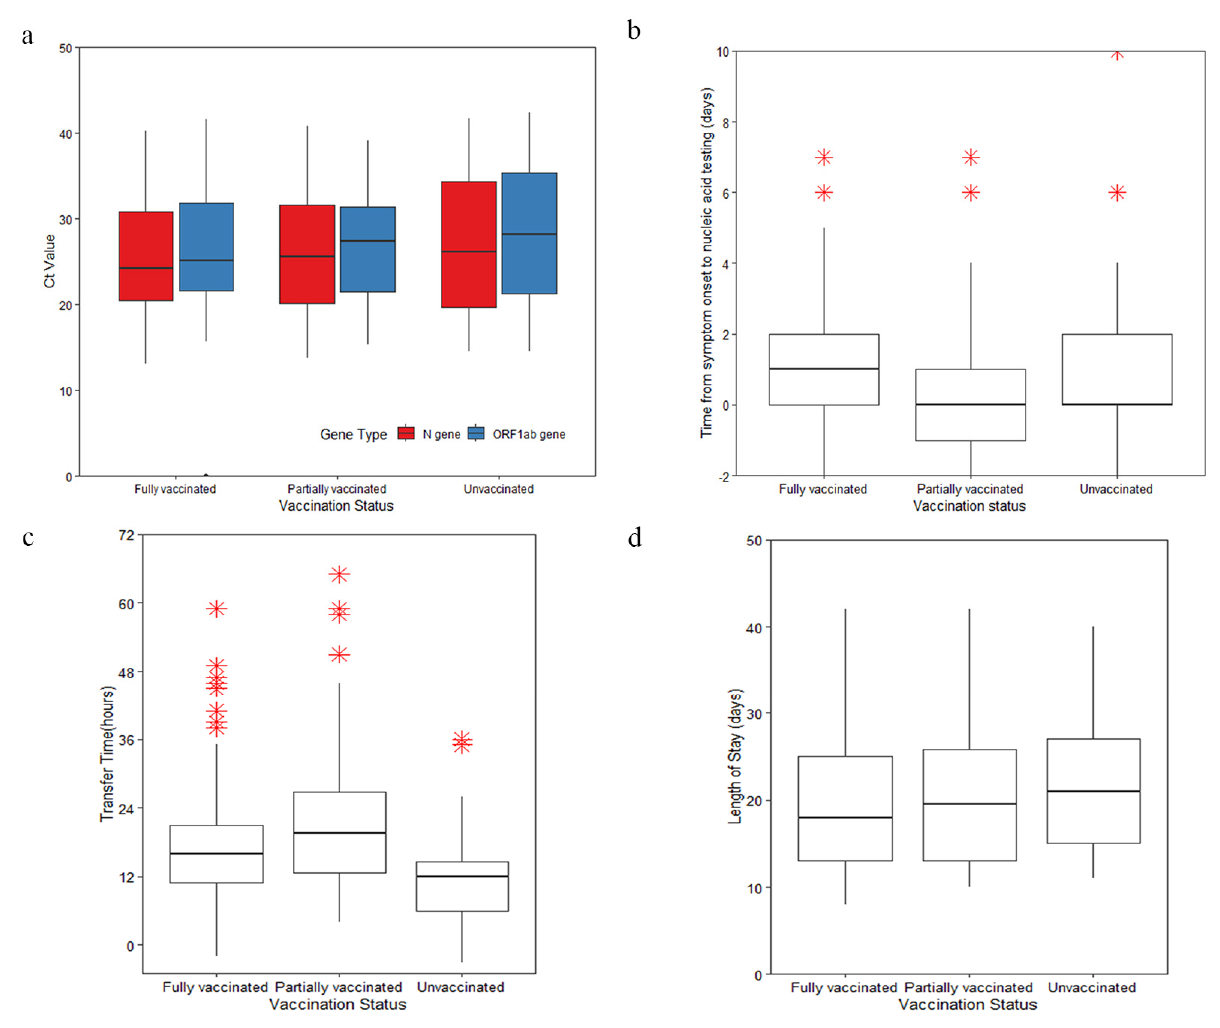
Figure 2. Epidemiological Characteristics of infected individuals. ( a ) Distribution of Ct values of positive nucleic acid test for ORF1ab and N gene in infected individuals by vaccination status; ( b ) Duration of time from symptom onset to nucleic acid testing in infected persons by vaccination status; ( c ) Duration of transfer time in infected persons by vaccination status; ( d ) Length of stay of infected individuals by vaccination status. Note: * means abnormal value.